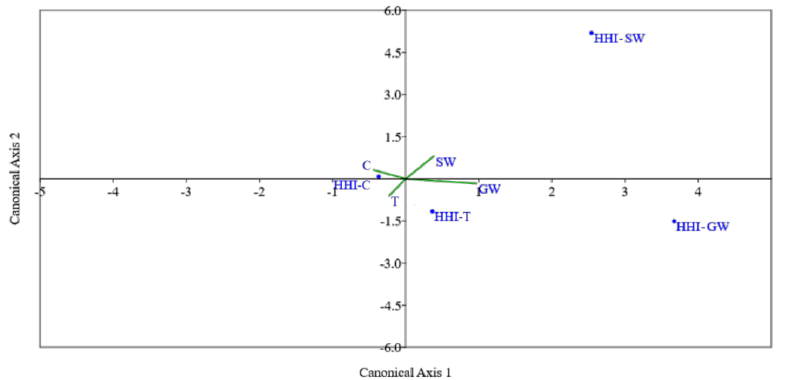
Figure 6. The canonical correspondence analysis (CCA) ordination of the ERI and HHI. Blue dots represent the HHI of crustaceans (HHI-CCA), tilapia (HHI-T), SW (HHI-SW), and GW (HHI-GW). The green lines represent the pERI of the crustaceans, tilapia, SW, and